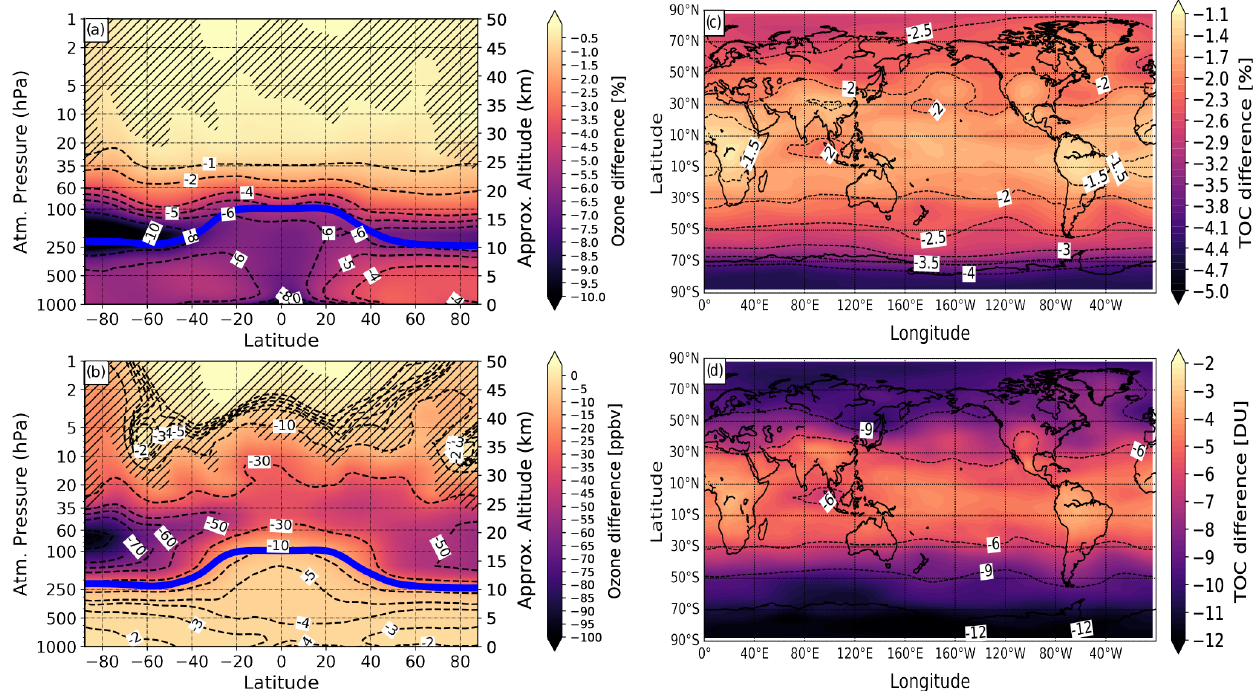
Figure 6. Modeled effect of iodine chemistry on annual-mean ozone climatology averaged for the 2000–2009 period and 10 ensemble members. (a, c) Ozone changes of the case with present-day iodine emissions (1 × iodine) relative to the control run (0 × iodine), presented as zonal mean ozone mixing ratios and total ozone columns (TOC) in percent. (b, d) Corresponding absolute ozone changes in parts per billion by volume (ppbv) and Dobson units (DU), respectively. Blue solid line in (a) and (b) : annual mean tropopause height. Hatching marks regions with iodine effect on ozone having a confidence level less than 95%.